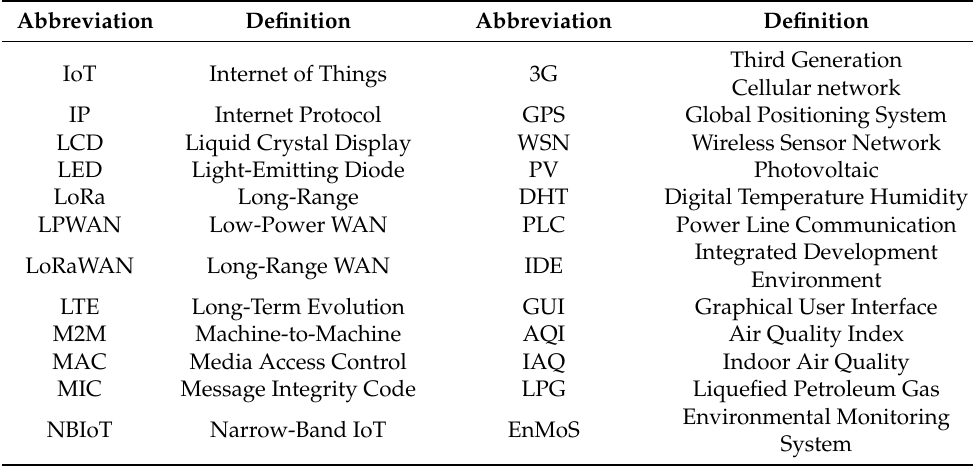
Table 1. List of abbreviations used in this